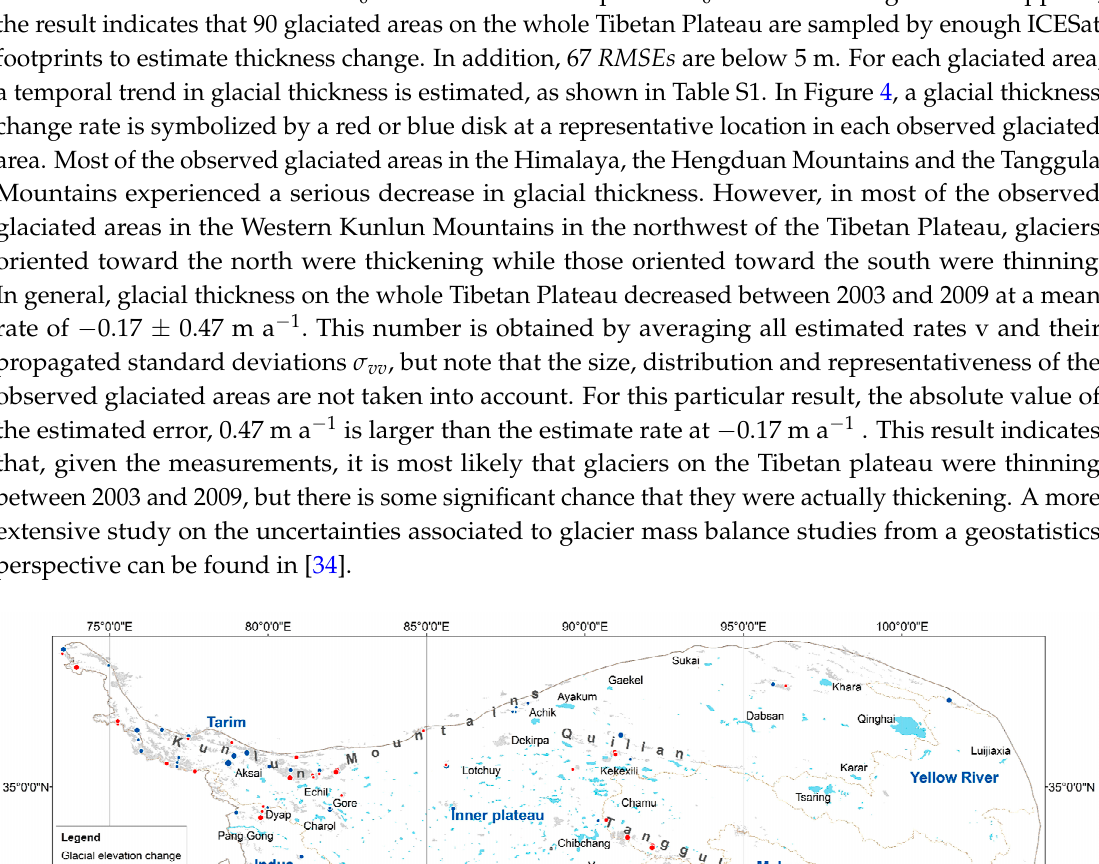
2013 indicates that in this area the glacier extent is relatively stable.